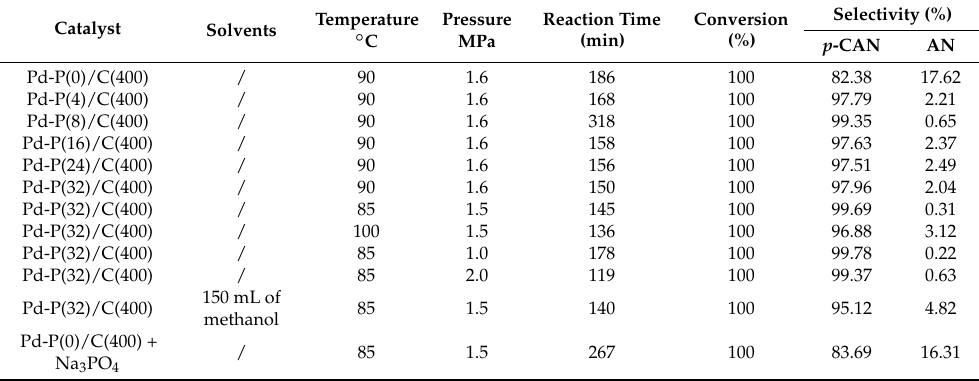
Table 2. Effect of phosphorus doping amounts on the selective hydrogenation of p -CNB under solvent-free